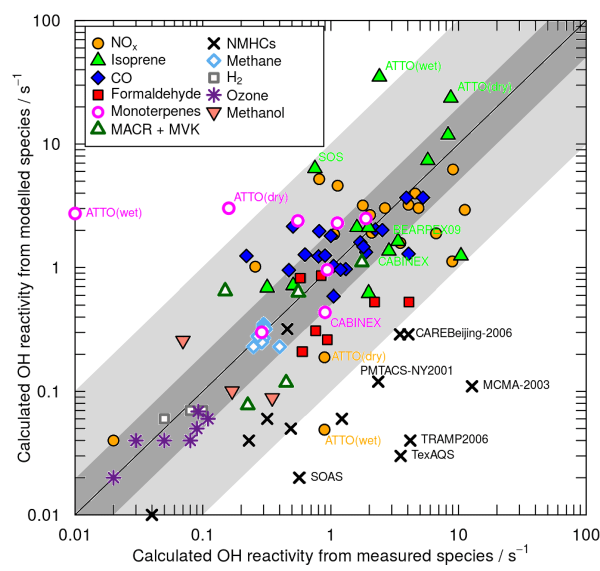
Figure 3. Scatter plot of modelled OH reactivity arising from known OH sinks against measurements. Also shown is the 1 : 1 line (solid black line) as well as the factor-of-2 and factor-of-10 devia- tions from it (dark-grey and light-grey areas respectively). Specific data points that are discussed in the text are labelled with the name of the field campaign in which those particular measurements were taken. Table 3. Outcome of the multiple linear regression (MLR). The pre- dictors are sorted by increasing p value.